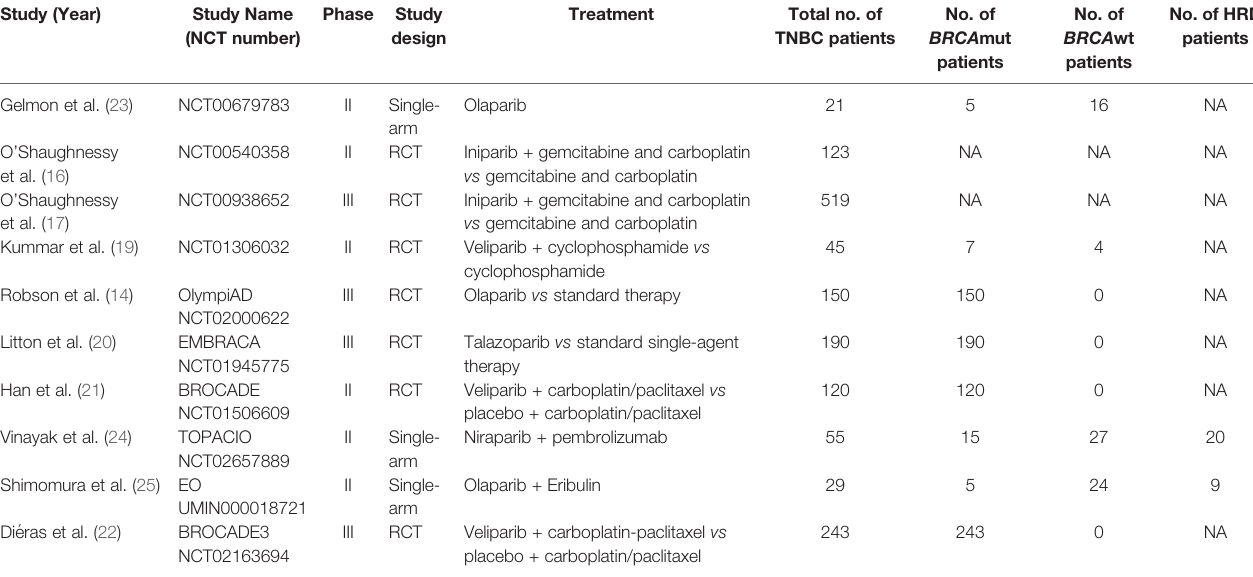
TABLE 1 | Characteristics of the selected